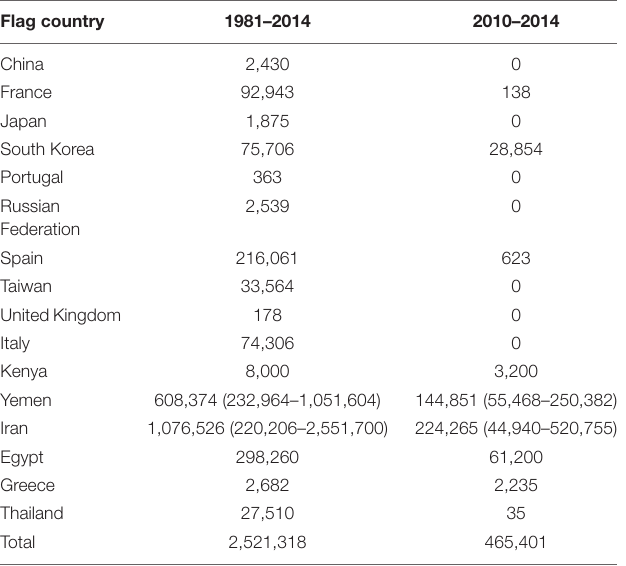
TABLE 1 | Catch (mt) of by foreign-flagged fishing vessels in Somalia’s exclusive economic zone. Flag country